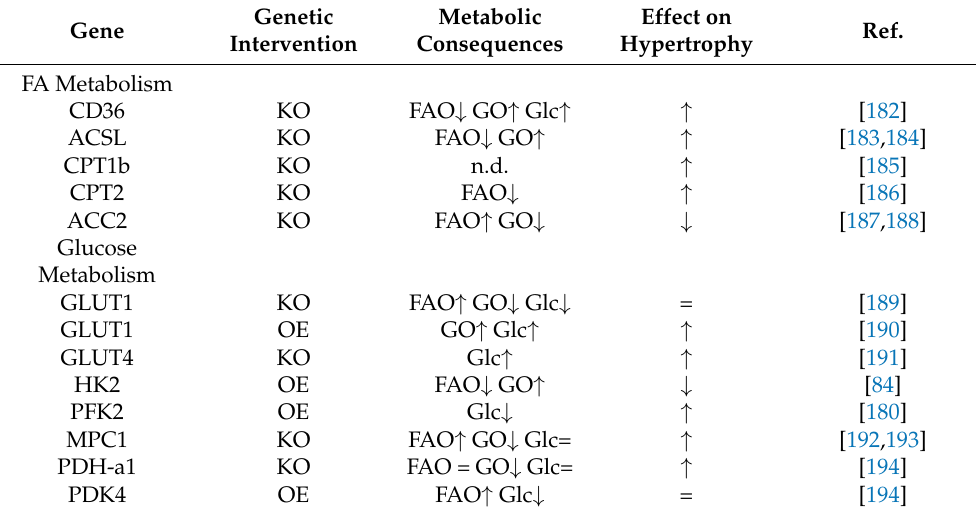
Table 2. Cardiac-restricted deletion or overexpression of metabolic genes affects hypertrophic growth. Genetic Metabolic Effect on Gene Intervention Consequences